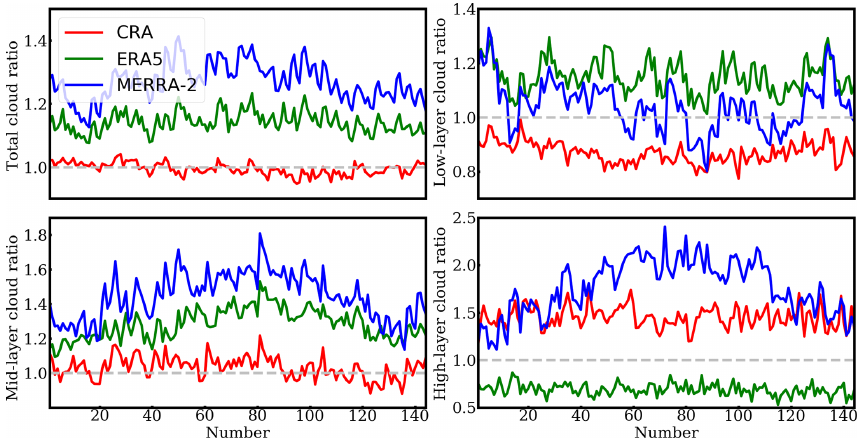
Figure 10. Same as Fig. 9 but for the results from 144 realizations spanning